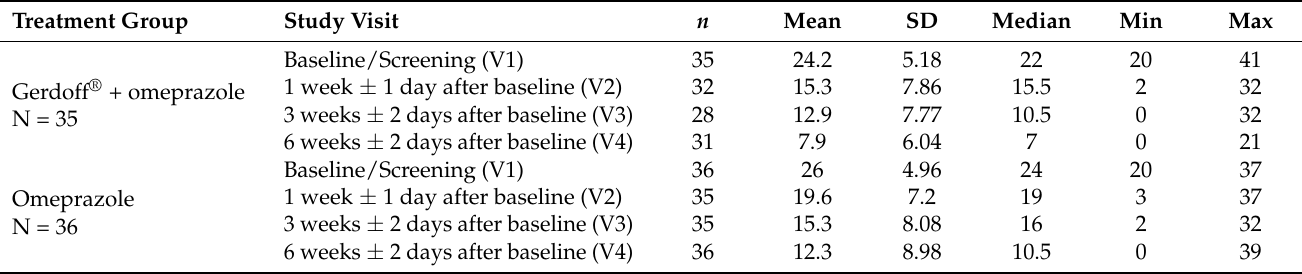
Table 2. Summary of total RSI score